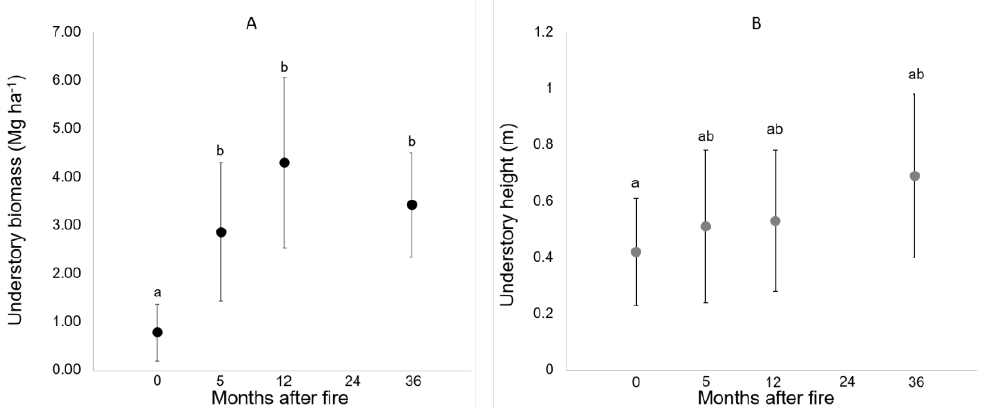
Figure 4. Mean ± stdev understory biomass ( A ) and height ( B ) at different months after a pre- scribed fire (June 2018) using the field harvest method. Here, 0, 5, and 12 represented the months when the measurements were collected after the fire and 36 the months since a 2015 fire but imme- diately before the 2018 fire (pre-fire). Note: LiDAR data was collected pre-fire- and five months post-fire.